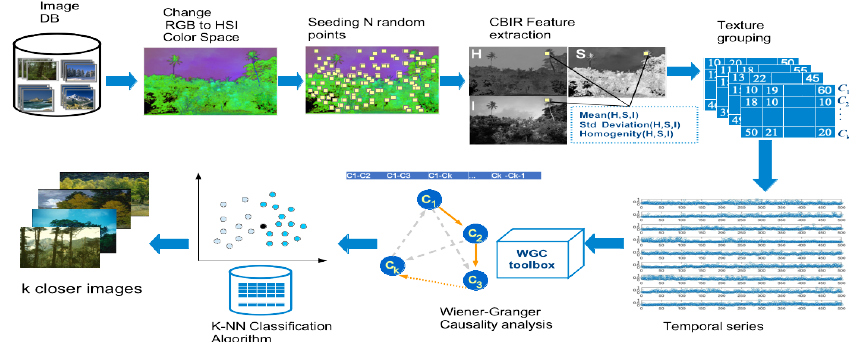
Figure 3. Training and test classification system architecture.